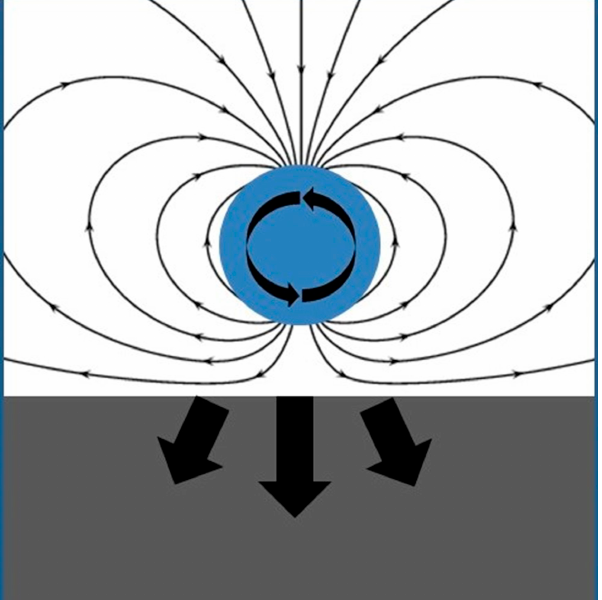
Figure 5. Geometry of simulation of rotating magnetized sphere above a highly conducting material. Magnetized, rotating sphere (blue) is shown above conducting material (gray). Arrows inside sphere indicate rotation and arrows in conducting material indicate force on the material. Arrows in air (white) indicate magnetic field lines at one moment in time. The axis of rotation is the y -axis, out of the plane of the figure. The magnetic axis of the magnetized sphere is initially in the x -direction and remains in the xz -plane.